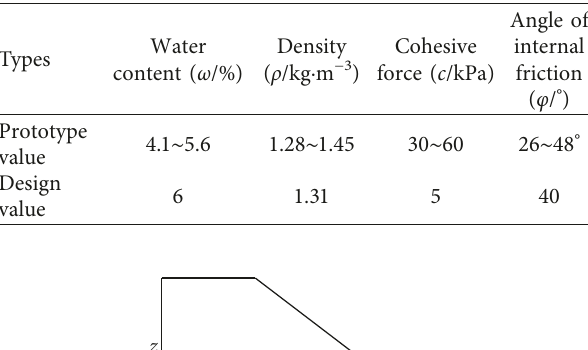
Table 1: Material similarity ratio.